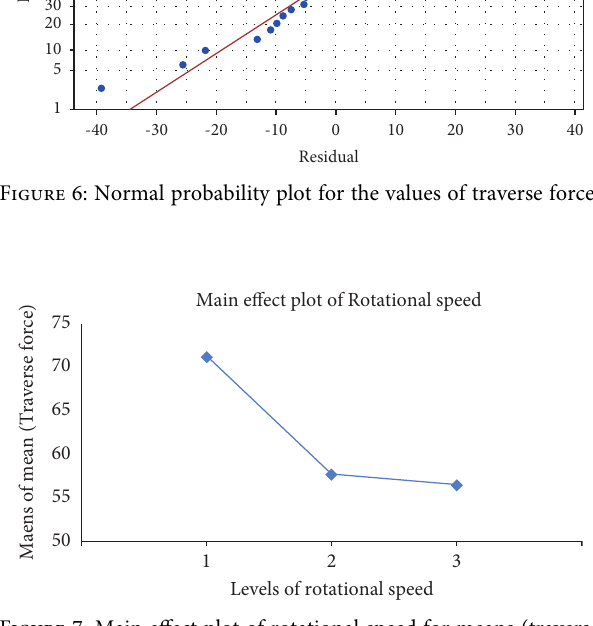
Figure 7: Main effect plot of rotational speed for means (traverse force).